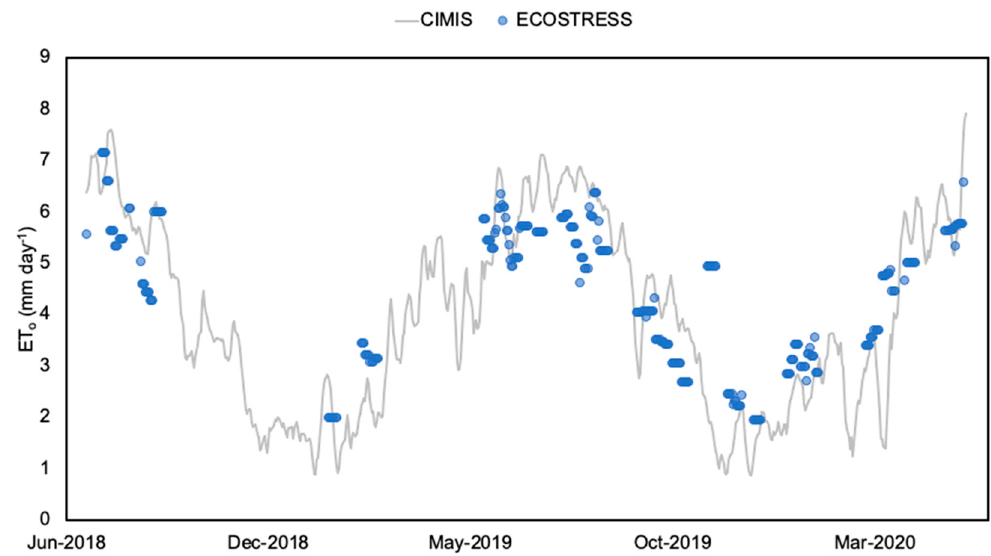
Figure 5. Seasonal time series using weekly composites of ECOSTRESS ET o (blue circles) and CIMIS ET o (grey line).